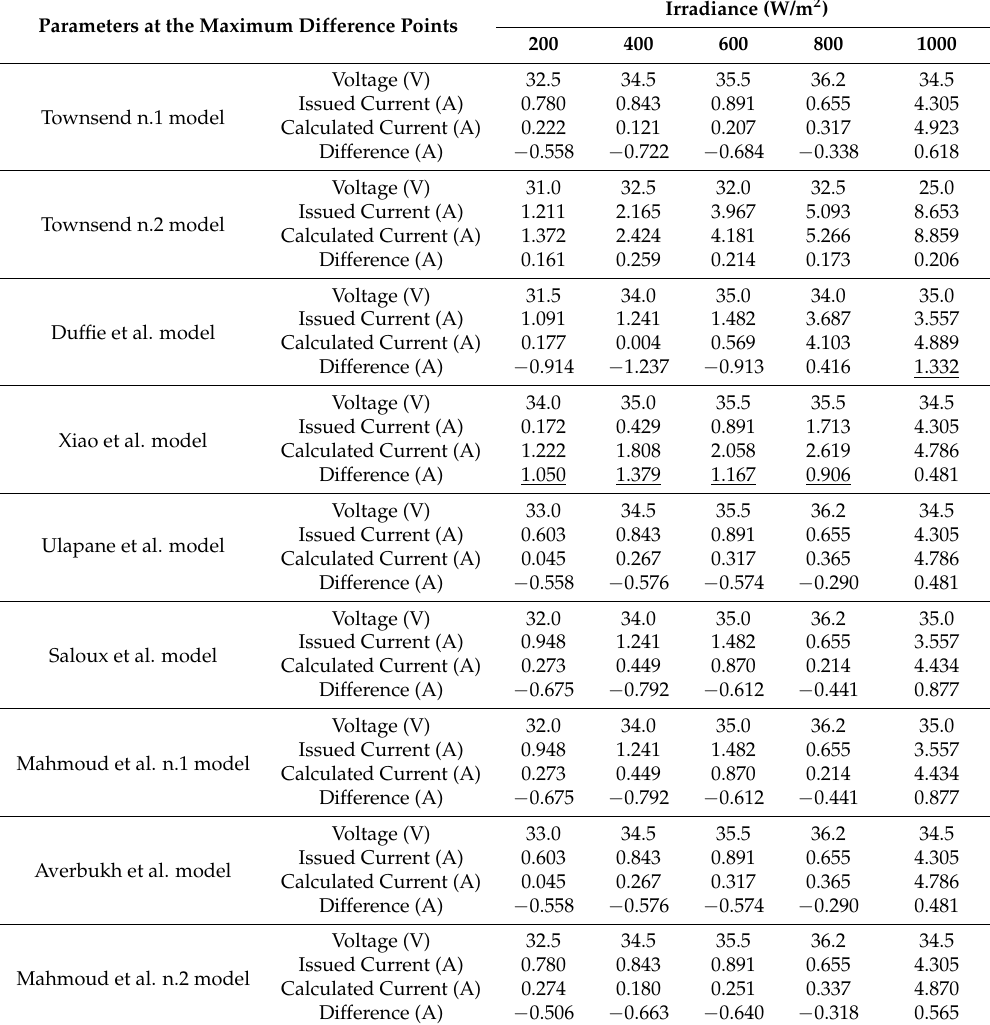
The underline represents the highest value of maximum current differences for each